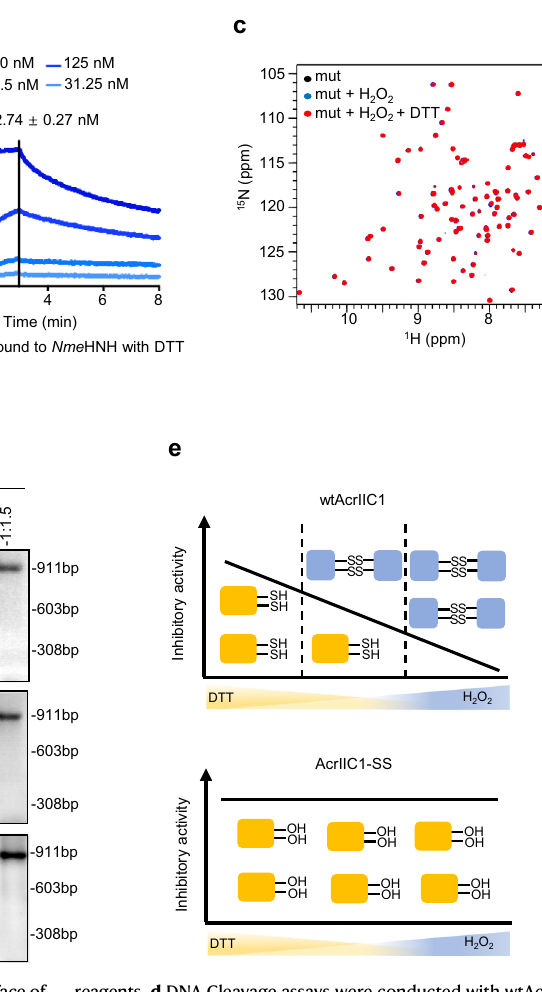
reagents. d DNA Cleavage assays were conducted with wtAcrIIC1 and AcrIIC1-SS under different redox conditions. Three reaction conditions were used: the redu- cingconditionwith1mMDTTinthebuffer(toppanel),thenon-reducingcondition withoutDTTorH 2 O 2 inthebuffer(middlepanel),andtheoxidizingconditionwith a fi vefold molar ratio of H 2 O 2 relative to Acr in the buffer (bottom panel). The experiments have been repeated more than three times with similar results. e Schematic representation of the inhibitory activities of wtAcrIIC1 (top) versus AcrIIC1-SS(bottom)underdifferentredoxenvironments.Sourcedataareprovided as a Source Data fi